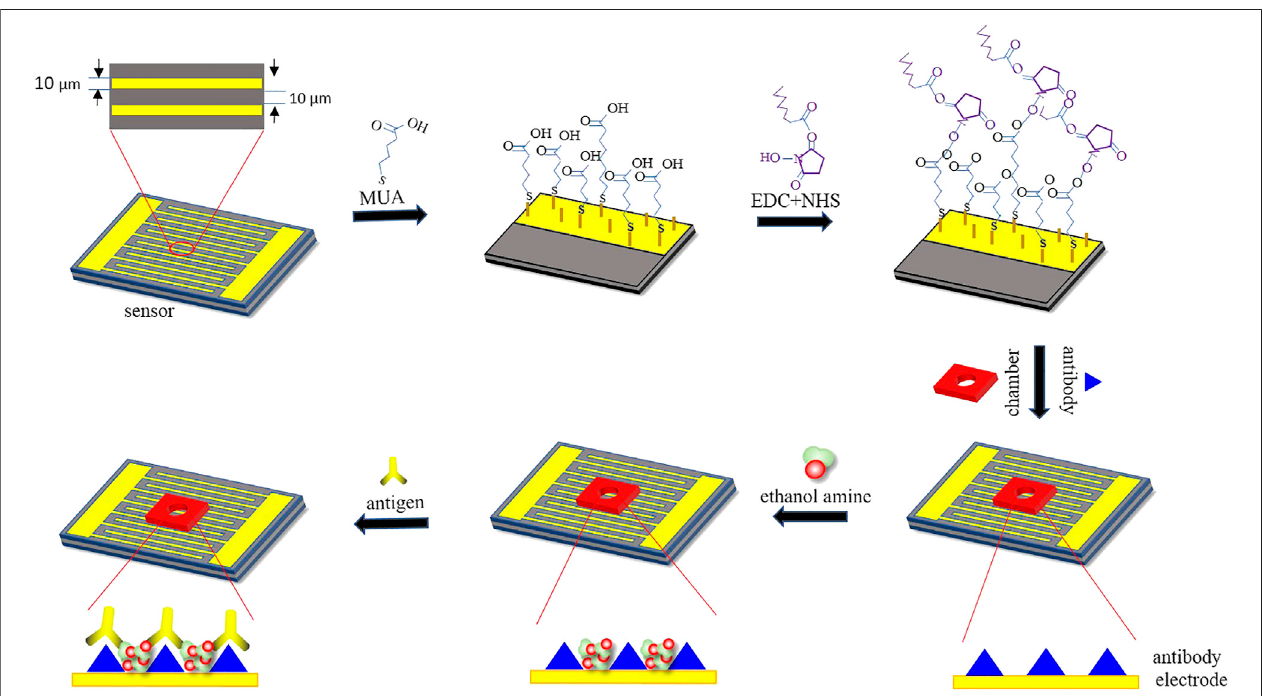
FIGURE 4 | Working principle diagram of the SAM-based biosensor. Reproduced with the permission from Luo et al. (2020).